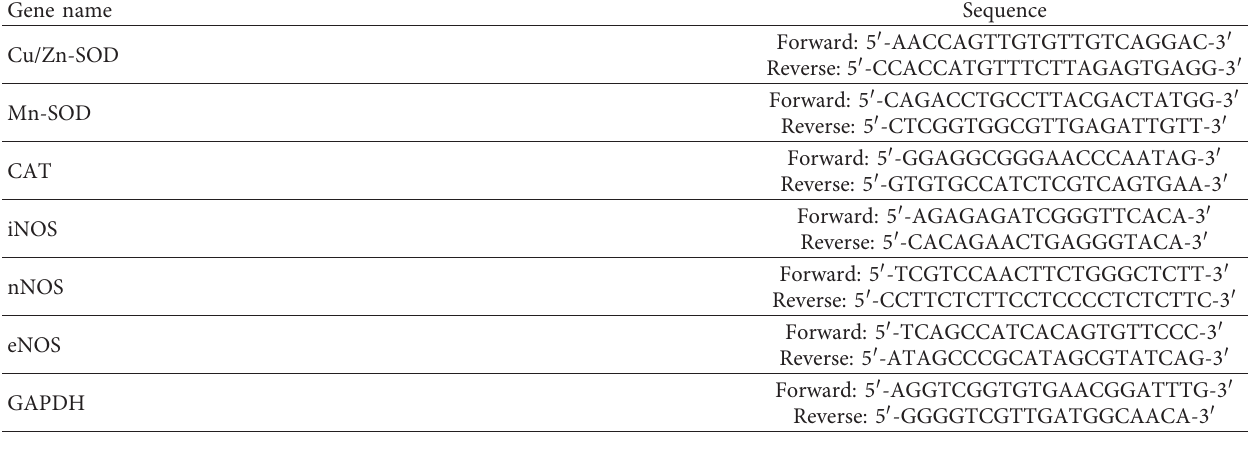
Table 2: Sequences of primers used in the qPCR assay.